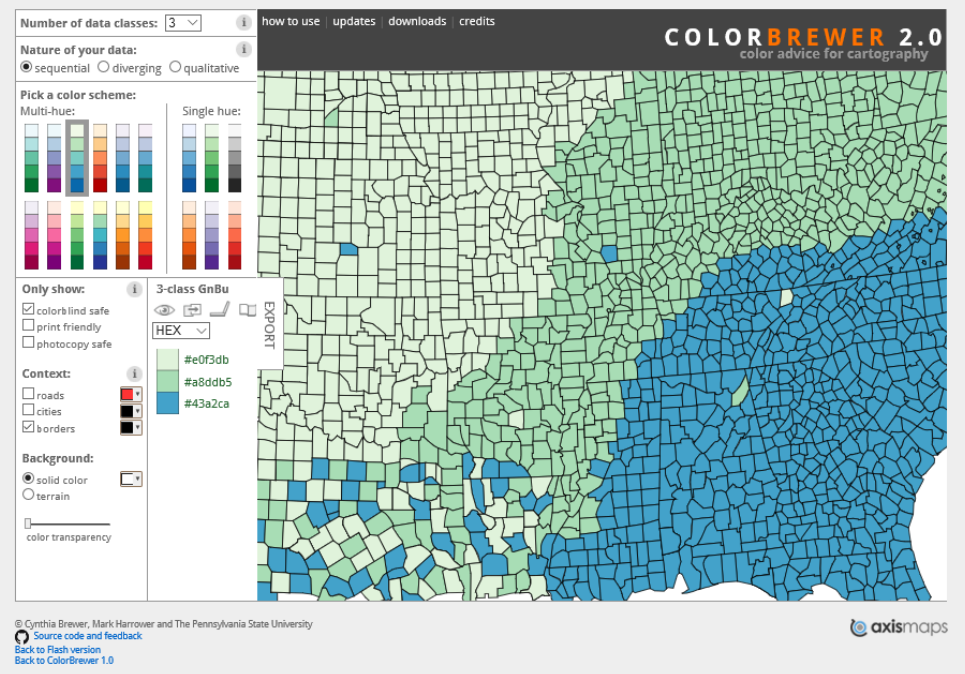
Figure 16: Chloropleth Example Generated Using